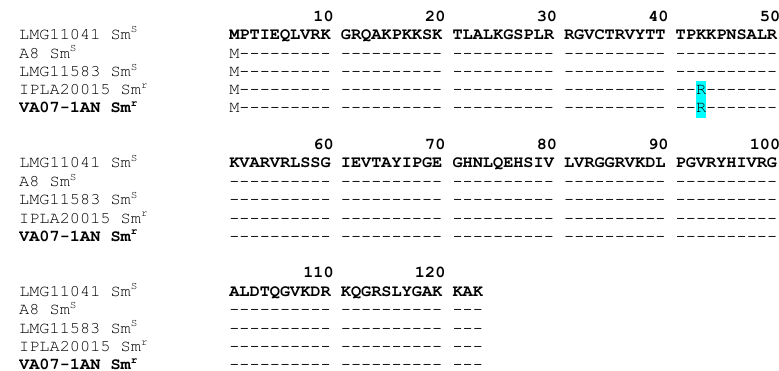
Figure 4. Alignment of the deduced amino acid sequence of S12 ribosomal proteins encoded by the rpsL gene from streptomycin resistant (Sm r ) and susceptible (Sm s ) Bifidobacterium bifidum strains. The amino acid replacement K → R at position 43 in the resistant strains is highlighted in pale blue. In bold, the strain of this study (VA07-1AN).